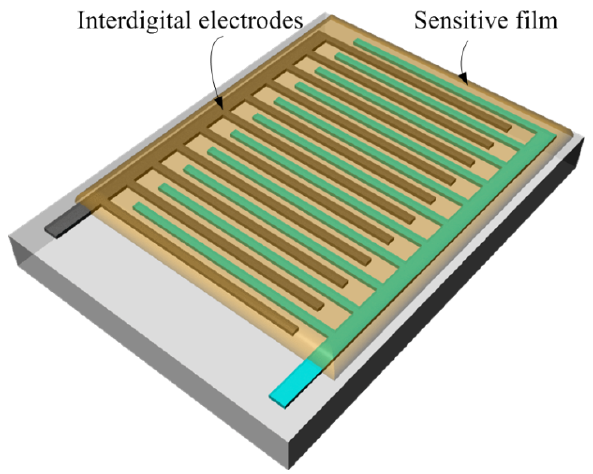
Figure 3. Schematic structure of the humidity